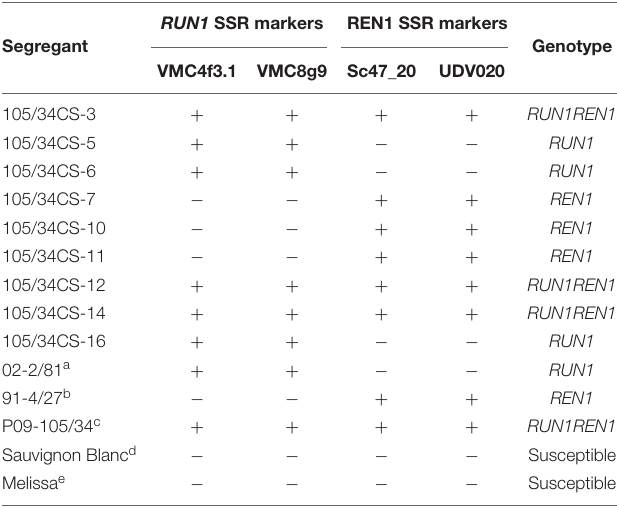
TABLE 1 | Marker assisted selection of grapevine segregants resistant to Erysiphe necator , carrying RUN1 and/or REN1